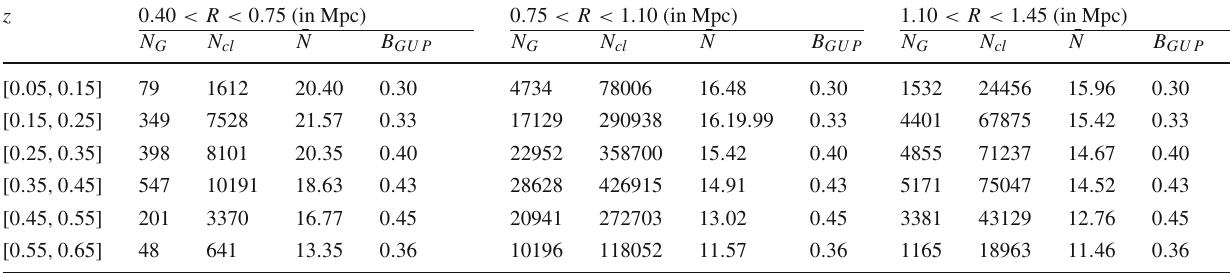
Fig. 4 The plots show the probability distribution function of galaxy clusters in red-shift bins and radius bins. The dotted lines represent the observational data points whereas the solid lines represent the theoretical model considered here Table 1 The table shows different parameters such as number of clusters N cl , number of galaxies N G , mean number of galaxies per cluster ¯ N and the value of the clustering parameter B GUP in various radius and red-shift